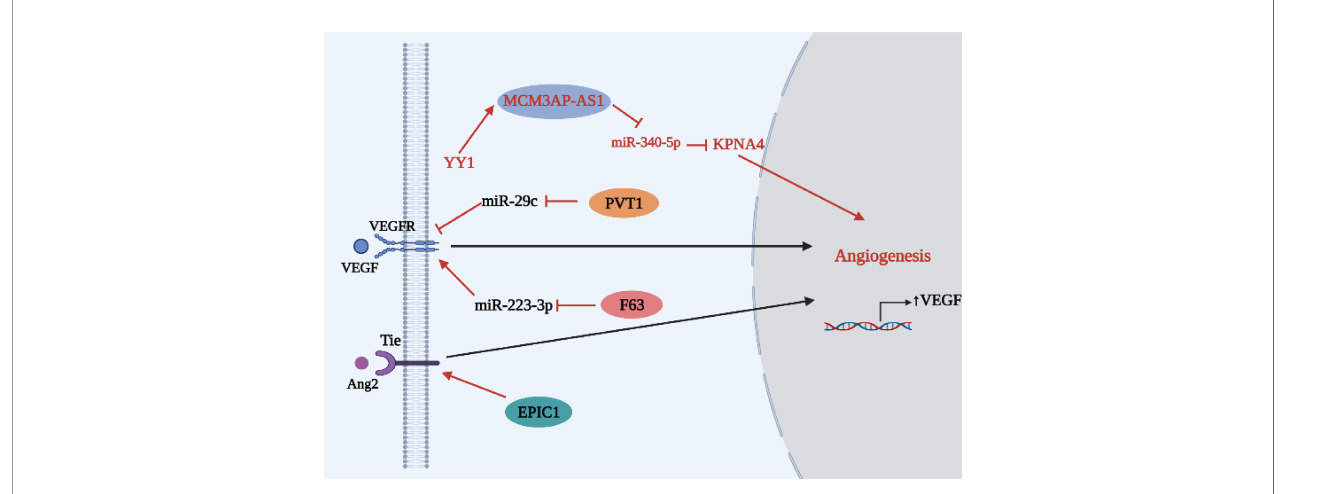
FIGURE 4 | Relationship between lncRNAs and angiogenesis in lung